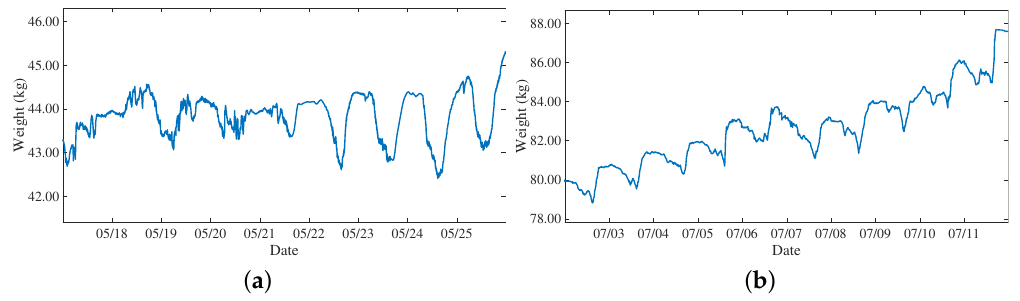
Figure 11. Second event: honey gathering derived from weight variations over one week: ( a ) spring season and ( b ) summer season.